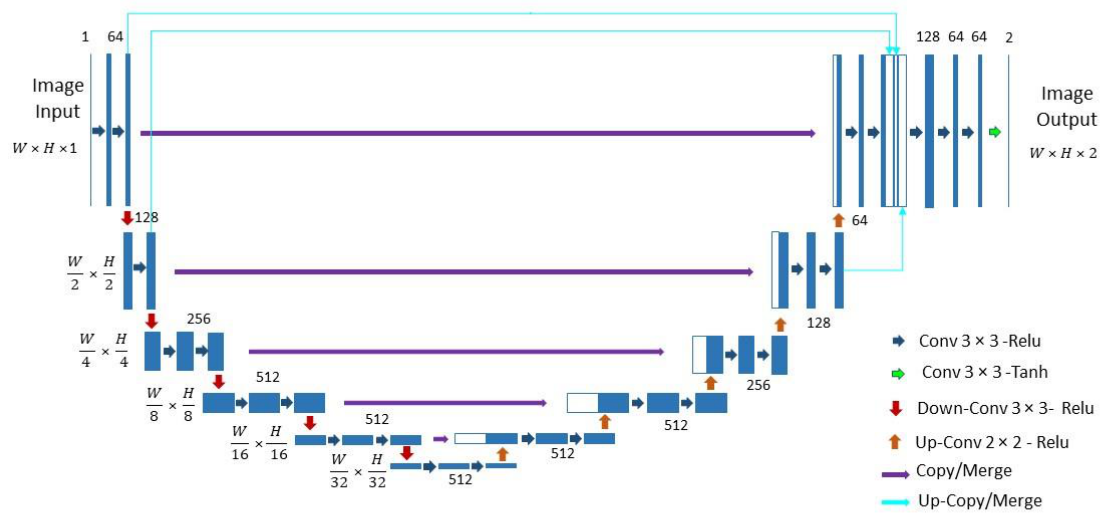
Figure 3. Architecture of the proposed Hyper-U-NET for the colorization of aerial grayscale